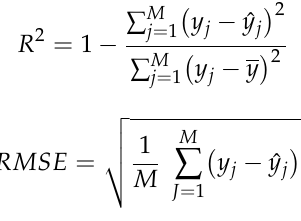
where Ann PR is the predicted results using the developed ANN model, and Actual is the actual values. The maximum percentage of the percentage error (MPRE) was set to